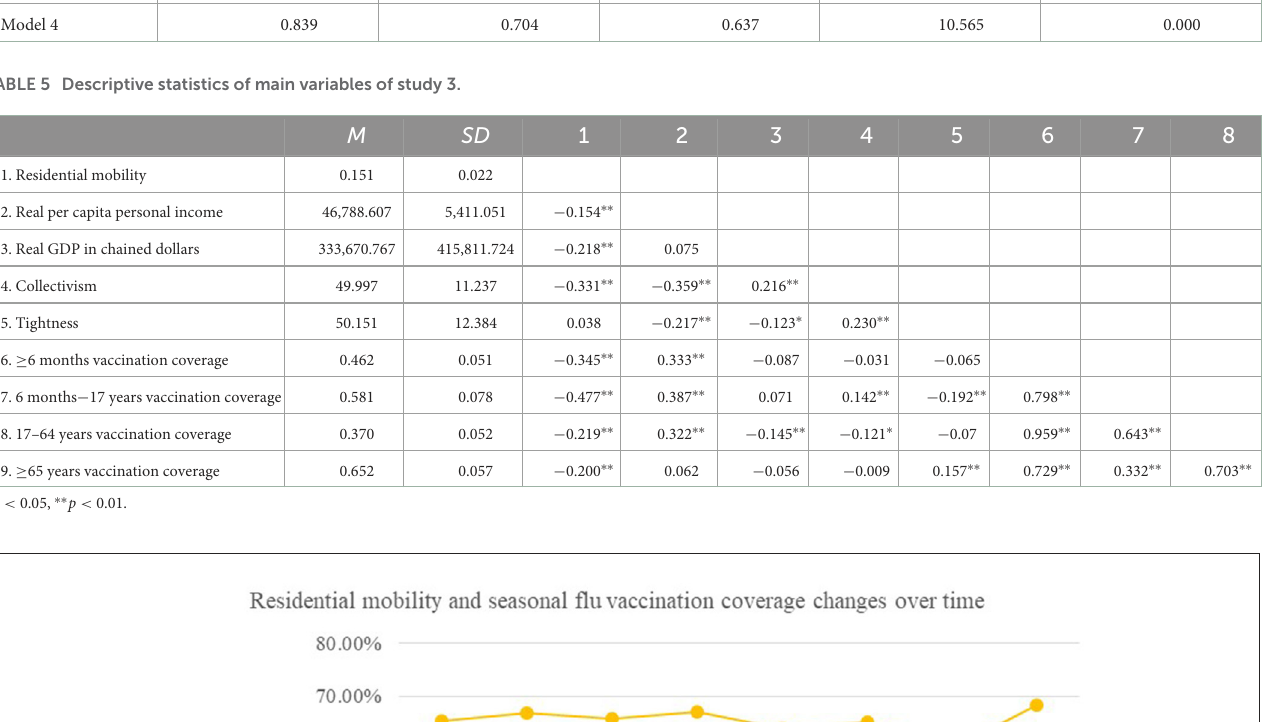
FIGURE1 Residential mobility and seasonal flu vaccination coverage changes over time.